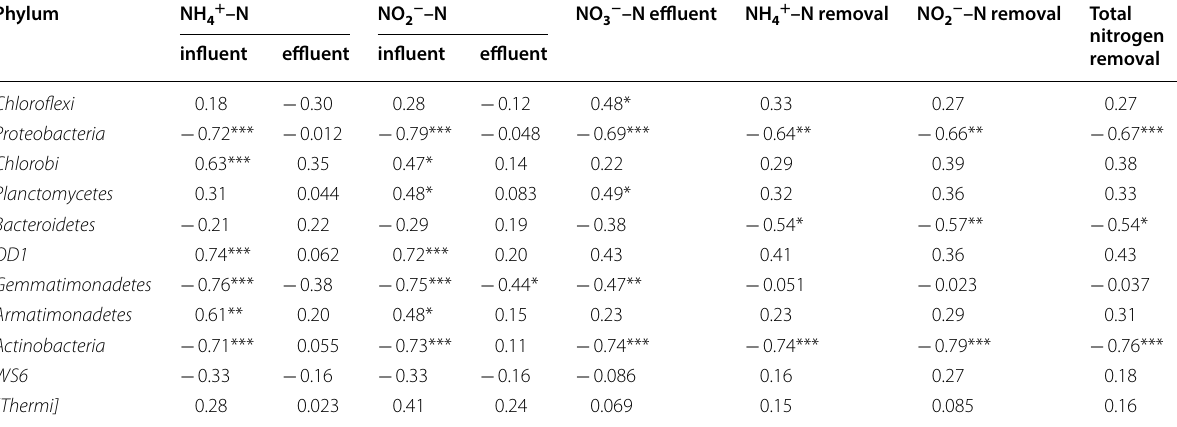
Table 2 Correlation ( R value) of relative abundance of major phyla to nitrogen